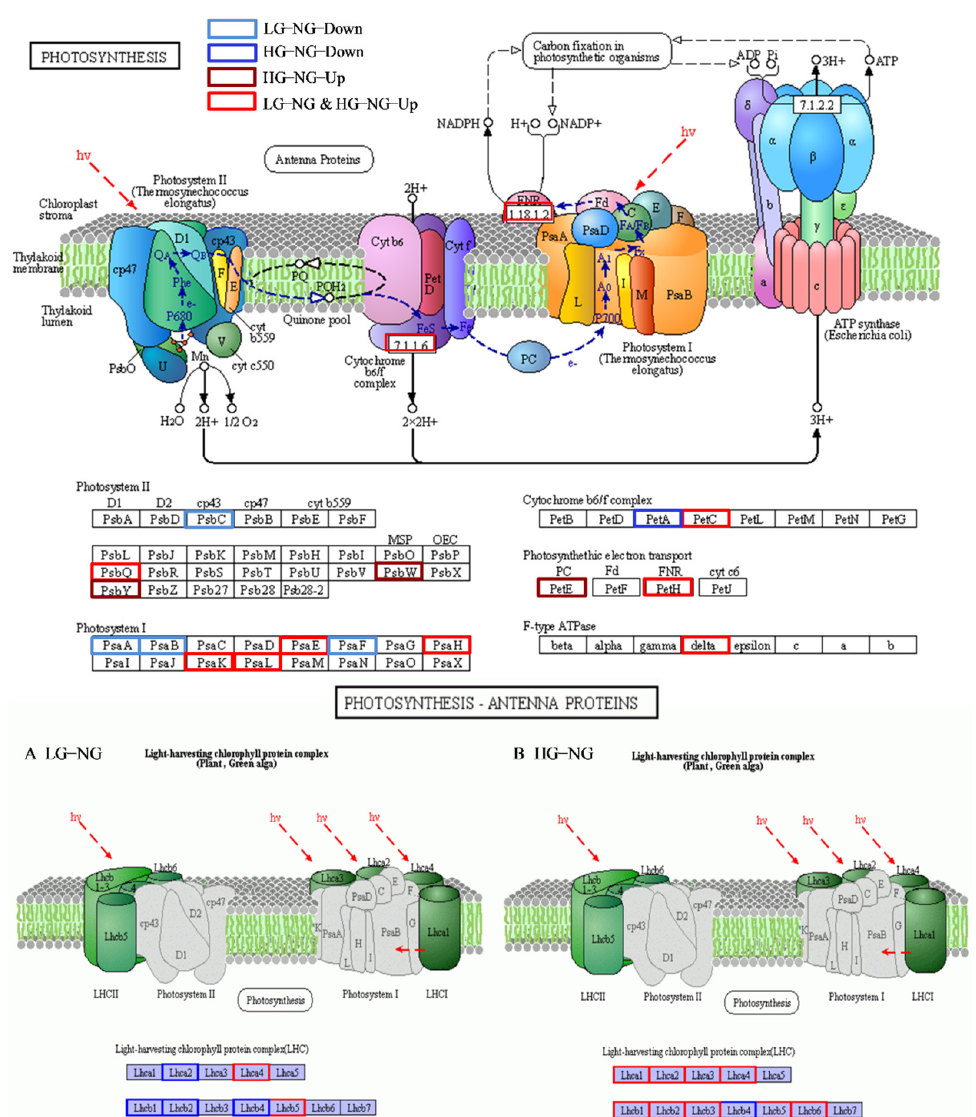
Figure 9. The DEGs about photosynthesis pathway and photosynthesis-antenna proteins in two grazing treatments. Blue blocks mean down-regulated genes in light grazing treatment vs. non-grazing treatment, dark blue blocks represent down-regulated genes in heavy grazing treatment vs. non-grazing treatment, dark red blocks indicate up-regulated genes in heavy grazing treatment vs non-grazing treatment, red blocks mean up-regulated co-expression genes in light grazing treatment vs. non-grazing treatment and heavy grazing treatment vs non − grazing treatment.